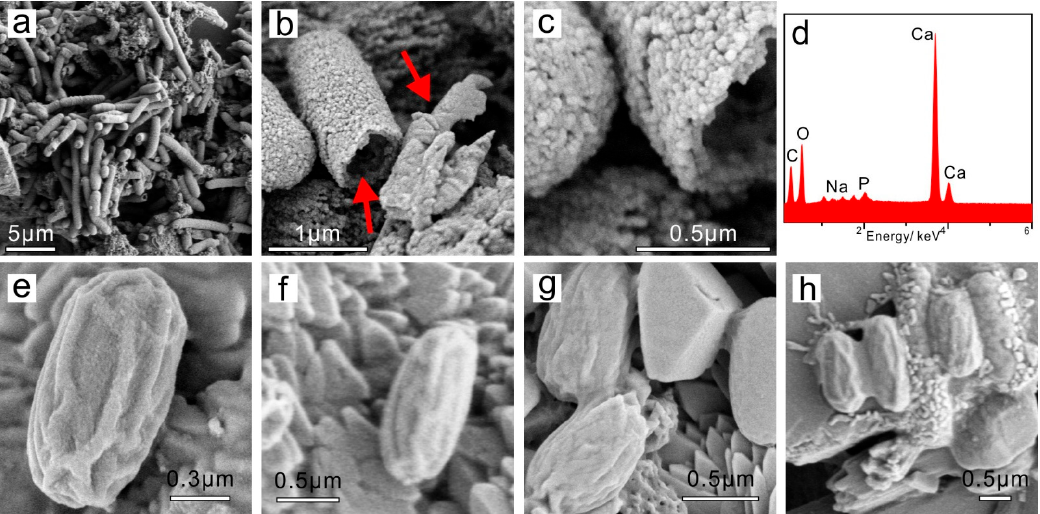
Figure 9. Scanning electron microscope images of the mineralized shells and SRB2 bacteria in the culture medium at different Mg/Ca molar ratios. ( a – c ) Mg/Ca = 0; ( d ) EDS analysis; ( e – h ) Mg/Ca = 6, 8, 10, and 12, respectively.